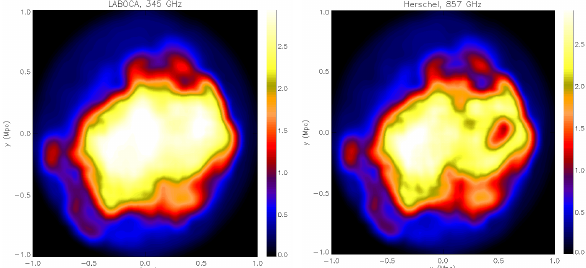
Figure 4: From top to bottom. The SZE signal to noise ratio map for the cluster 1E0657-558 at 345 GHz smoothed to the resolution of LABOCA and at 857 GHz smoothed to the resolution of Herschel-Spire. Figures from